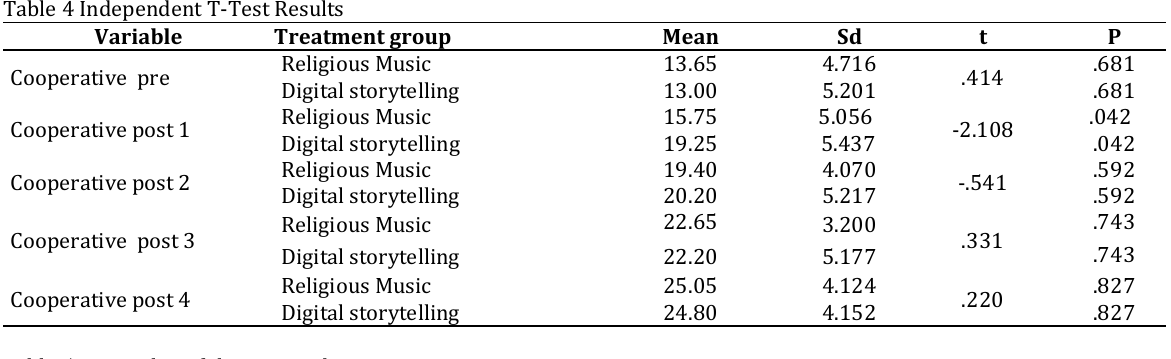
Table 5 Pain Value of the Respondents Treatment group